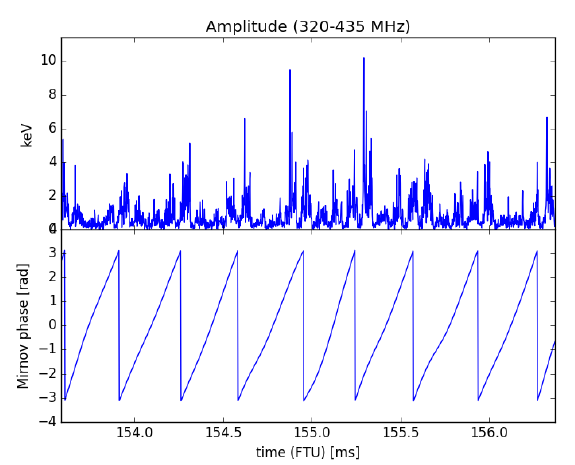
Fig. 6. Amplitude of emission between 0.32-0.435 MHz from the probe (Top), compared to the phase of the Mirnov coil signal (Bottom) for shot #40753: for this shot a correlation is found, while in other ones (#40771 and #40772) it is not .